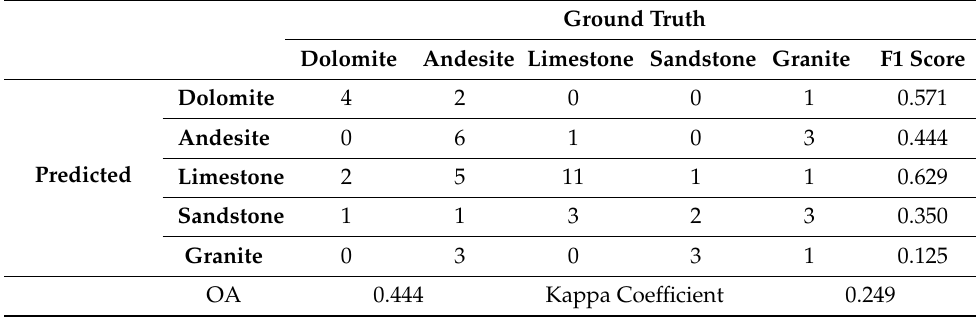
Table 3. Confusion matrix of cross-validation using